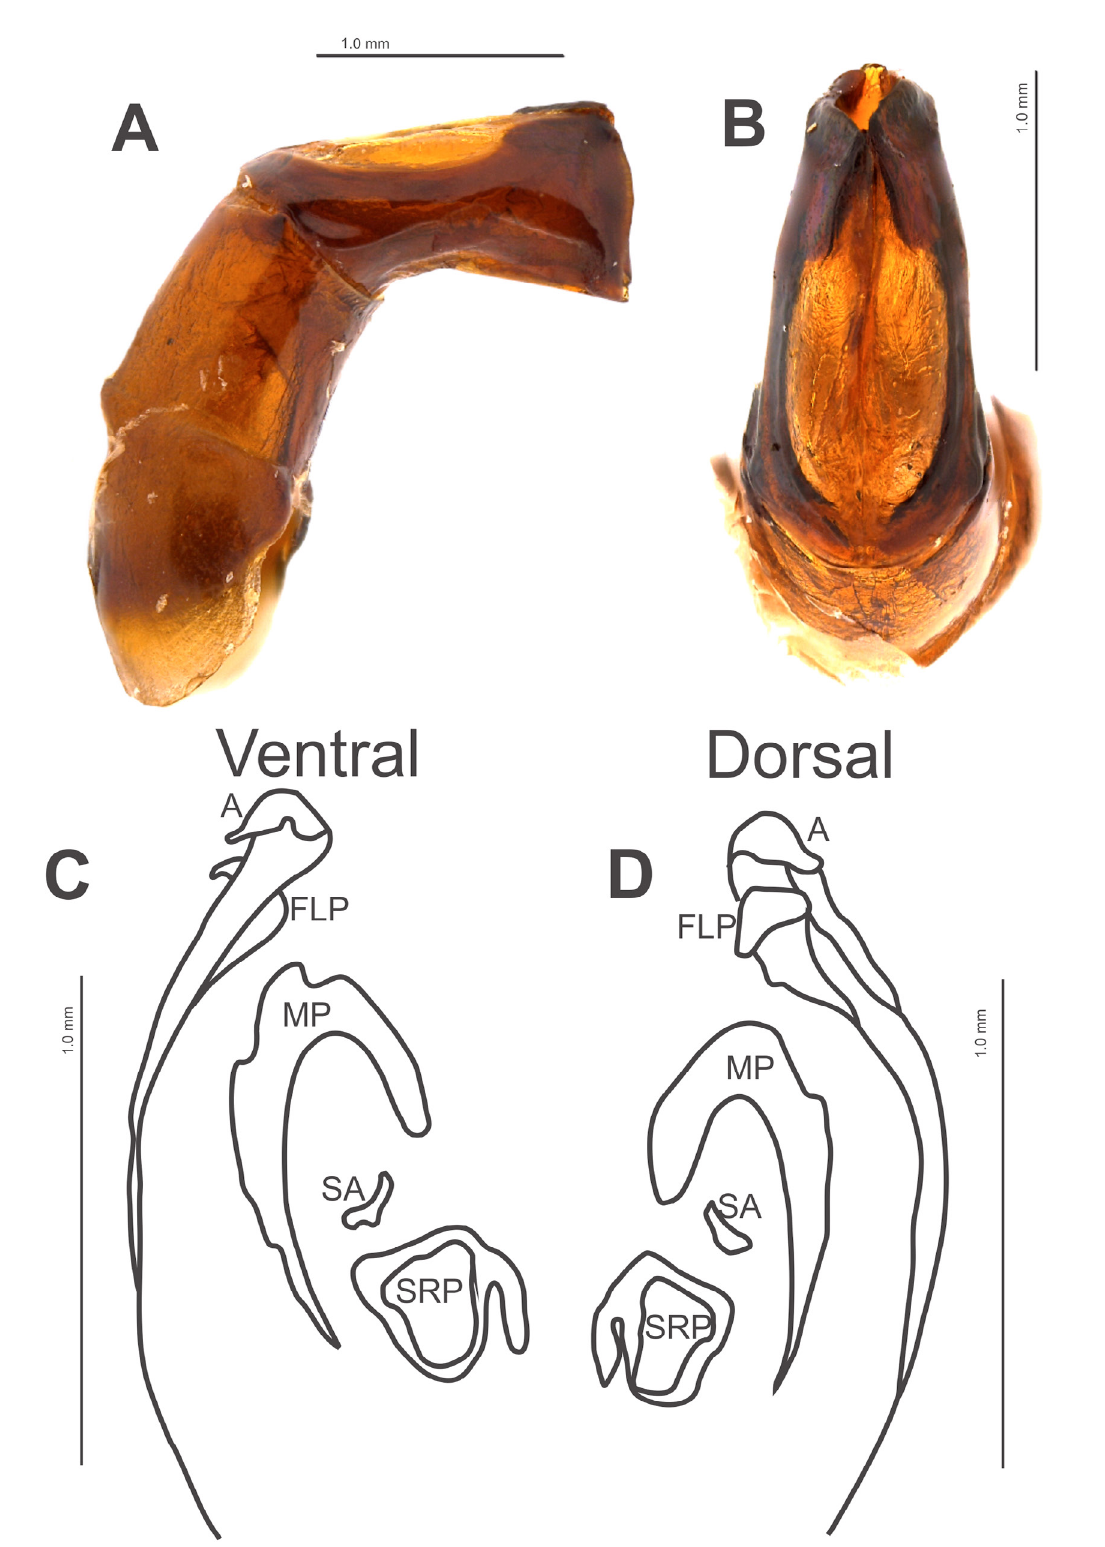
Fig. 8. Canthon ( Peltecanthon ) terciae sp. nov., paratype, ♂, Rio Grande do Norte, Baia Formosa, Mata Estrela (CEMT). A . Parameres lateral view. B . Parameres dorsal view. C . Internal sac ventral view. D . Internal sac dorsal view. Abbreviations: see Material and